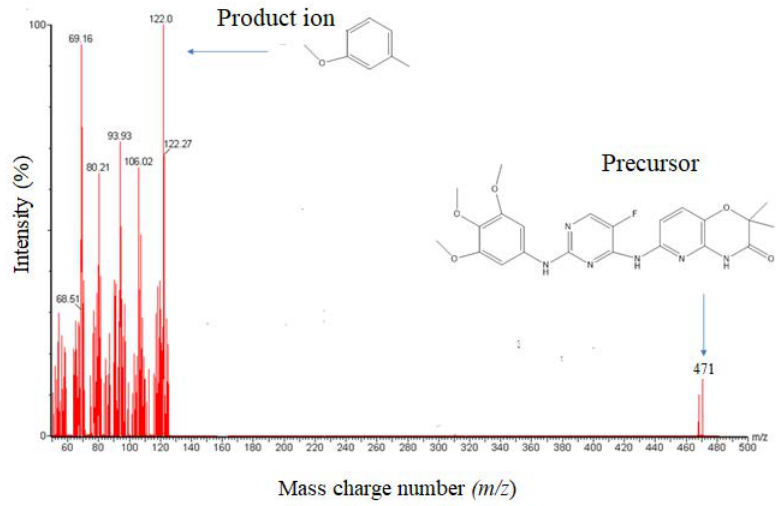
Figure 1. Typical Representation of Precursor-to-Product Ion Spectra of Tamatinib using ESI Positive Ionization